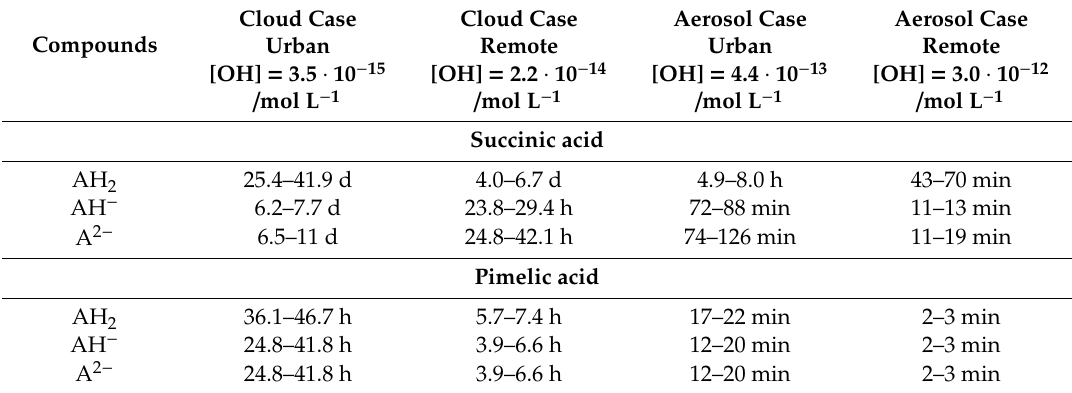
Table 5. Atmospheric aqueous-phase lifetimes calculated for urban and remote